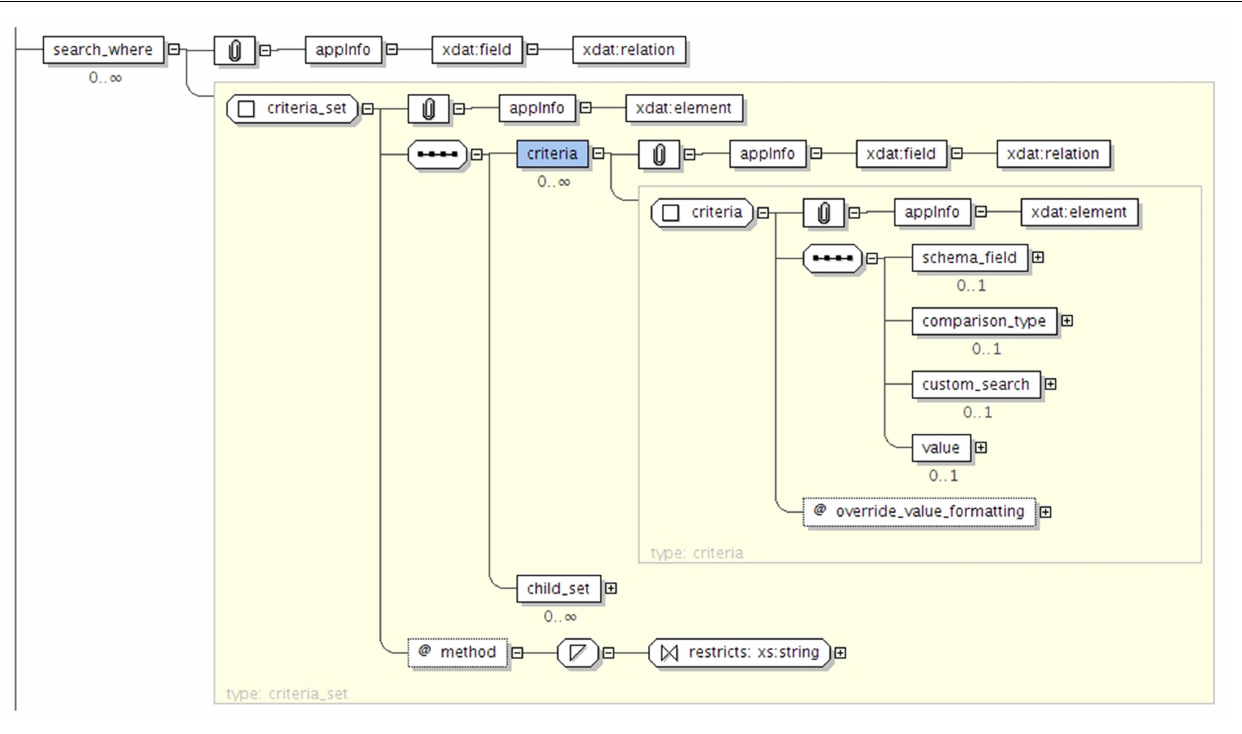
FIGURE 3 | XML Schema for the search